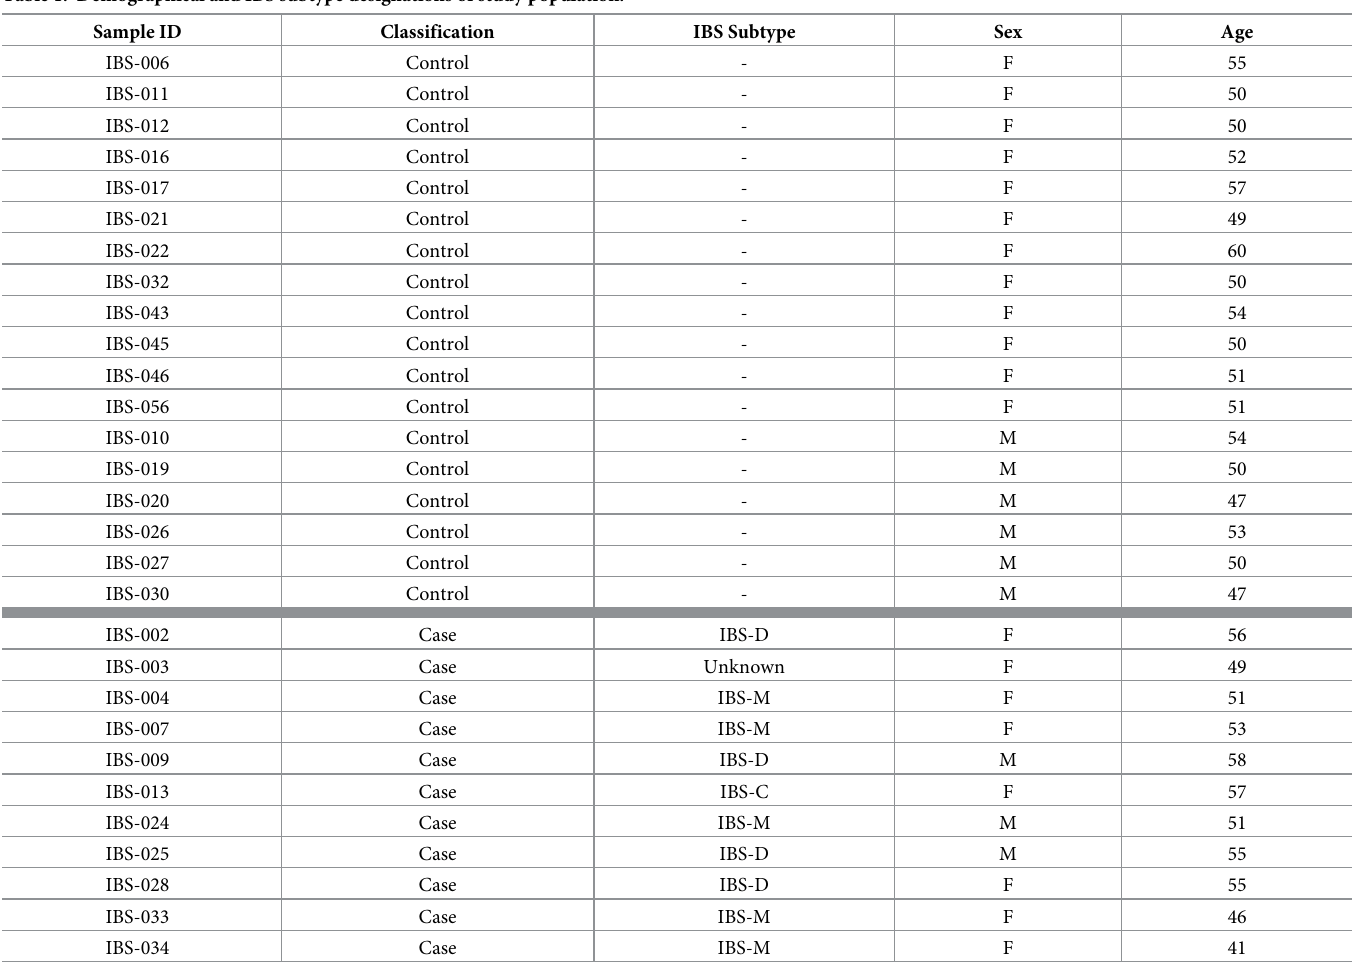
Table 1. Demographical and IBS subtype designations of study population. Sample